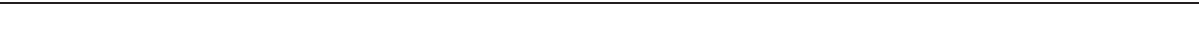
Fig. 6 Arp2/3-based actin machinery is required for CG endocytosis. a Histograms (top) show quanti fi cation of fl uid phase and TfR uptake in AGS cells treated with DMSO alone (0 µ M) or the indicated concentrations of ARP2/3 inhibitor, CK666, normalised to DMSO-treated controls, along with its representative images (below). Data are pooled from two independent experiments and the number of cells shown indicated the graph. b – d Graphs show the average normalised fl uorescence intensity vs. time traces for the recruitment of mCherry-ARP3 ( b ), pRuby-Lifeact ( c ) and mCherry-NWASP ( d ) to the forming SecGFP-GPI endocytic sites, and its corresponding random intensity trace ( n , Table 1). The random traces were derived from randomly assigned spots of the same radius as the endocytic regions, as detailed in S.I. Endocytic distribution at each time point was compared to the random distribution by Mann – Whitney U test and the log 10 ( p ) [log 10 (0.05) is − 1.3 and log 10 (0.001) is − 2.5] is plotted below each trace ( b – d ). Representative montages are depicted below the graphs. Arrowheads indicate the newly formed endocytic vesicle. e Histogram (left) shows normalised 5-min mean fl uid-phase uptake in AGS cells overexpressing pIRES-CA domain, GFP-VCA domain and GFP-N-WASP Δ VCA from N-WASP compared to un-transfected cells and representative images (right). The transfected cells are outlined. Data were pooled from two independent experiments and the number of cells shown below the graph. Error bars represent s.e.m. ( b – d ) and s.d. ( a , e ). p value <0.01 (*), and 0.001(**) by Mann – Whitney U test ( a , e ). Scale bar, 1.5 µ m ( b – d